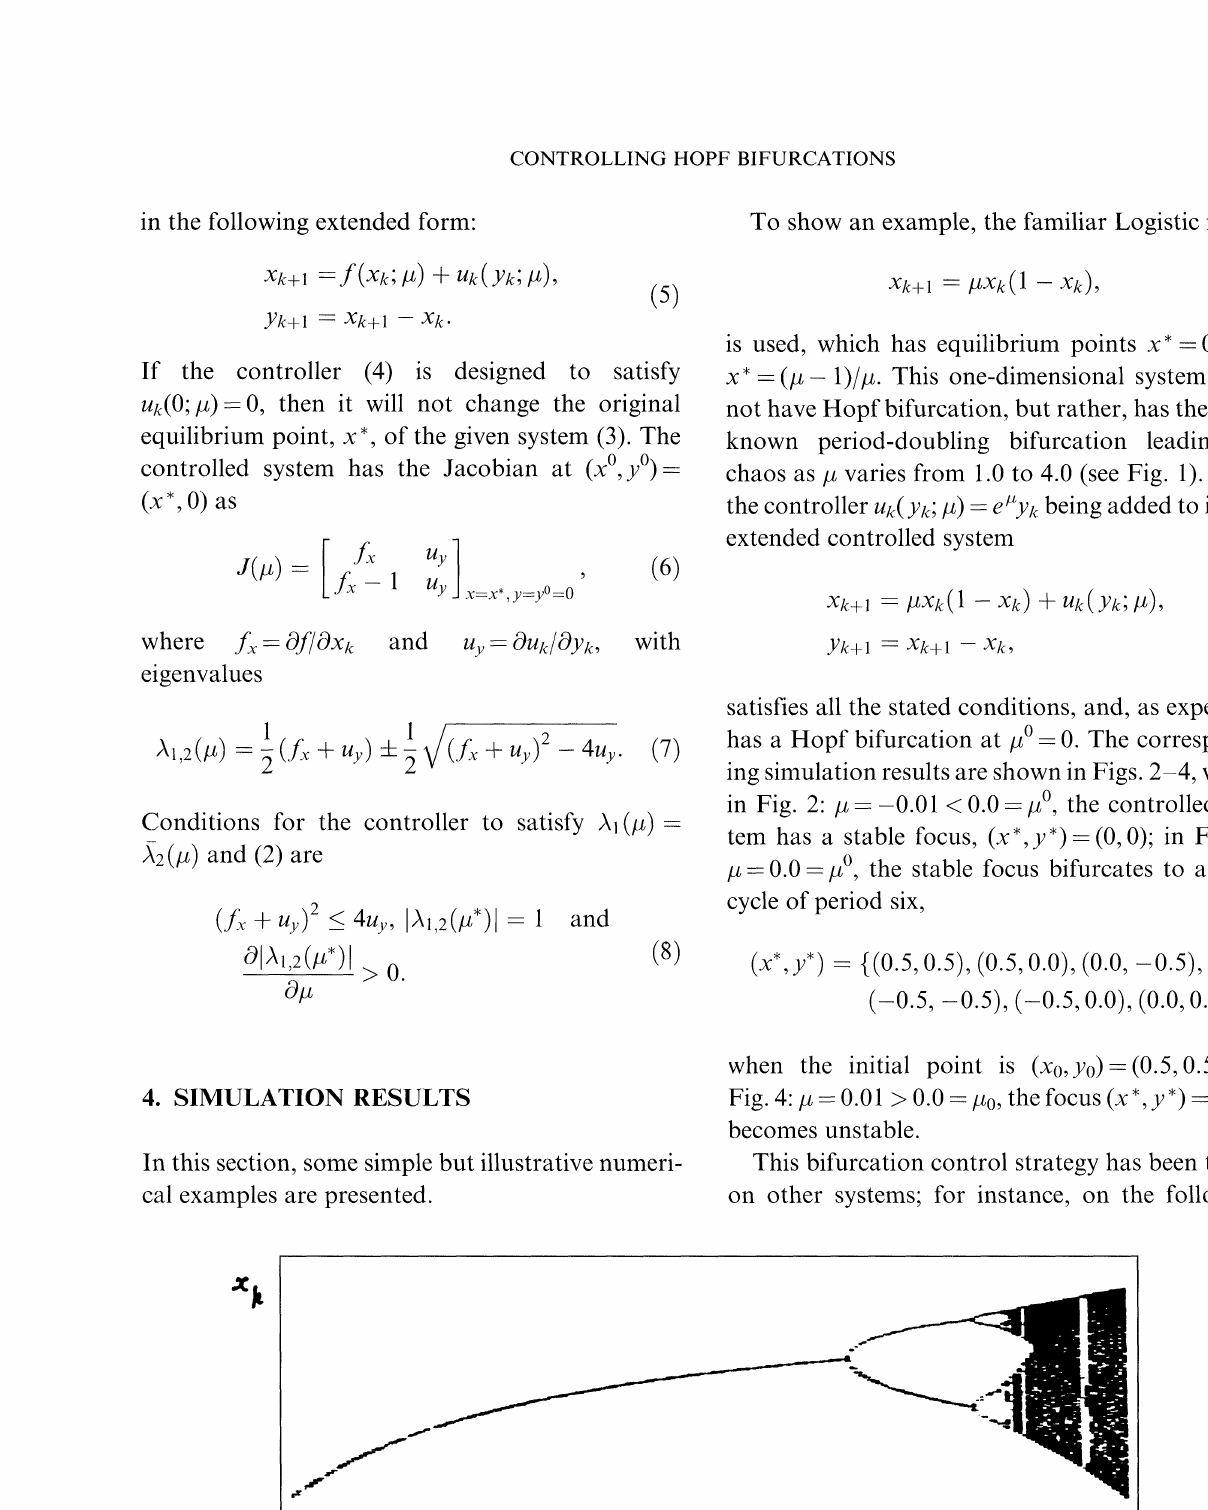
Period-doubling bifurcation of the Logistic map (1 < # _<